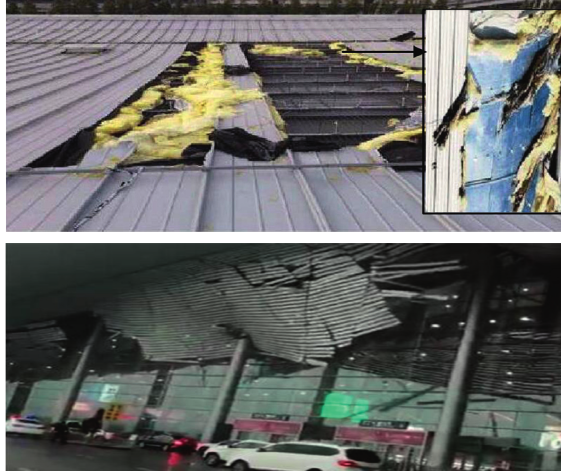
Figure 2: The metal roof of airport lifted off by